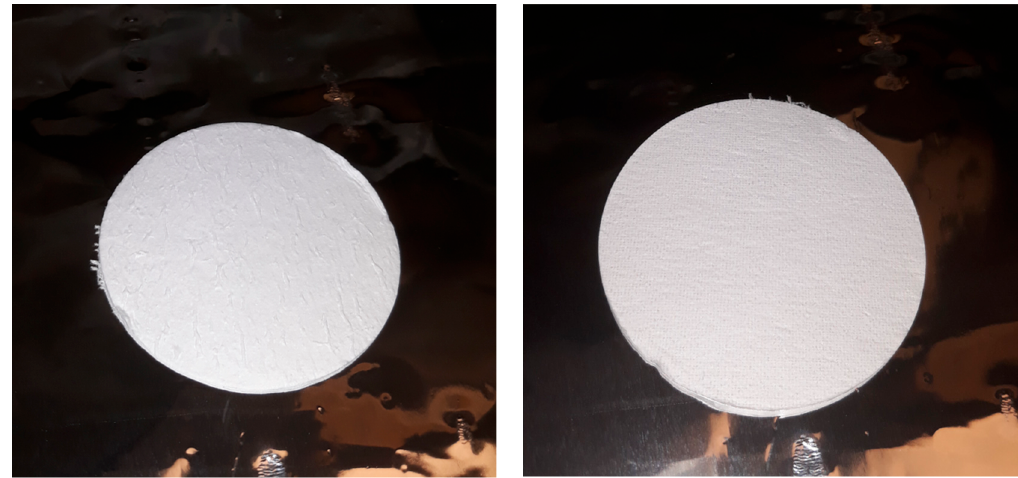
Figure 2. A filter right side up (left picture) and wrong side up ( righ t picture).